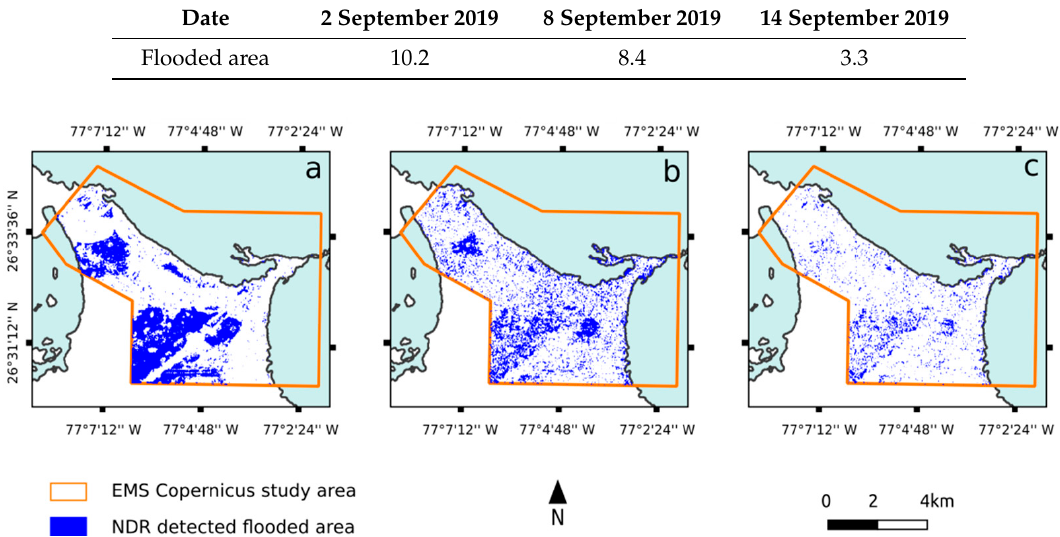
Figure 12. Map of flood extend in Marsh Harbour area between 2 September 2019 and 14 September 2019. ( a ) 2 September 2019; ( b ) 8 September 2019; ( c ) 14 September 2019.